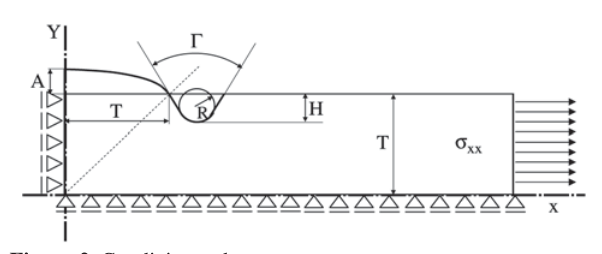
Figura 2. Condiciones de contorno